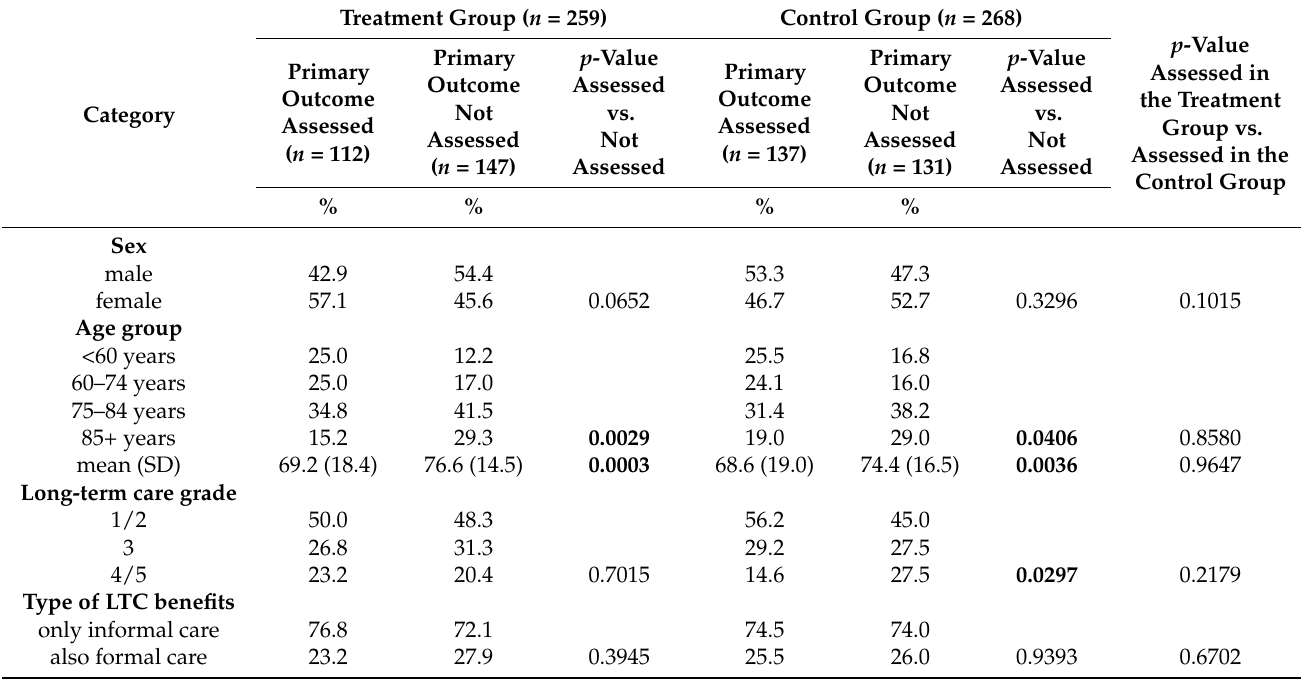
Table 1. Characteristics of the treatment group and control group participants whose outcomes were assessed/non-assessed.